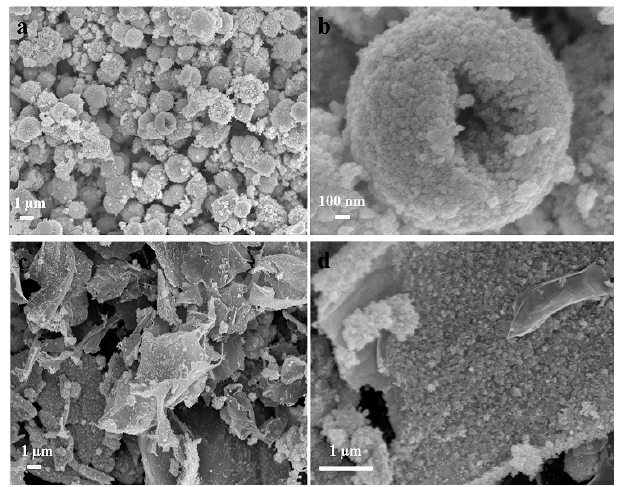
Figure 2. Field-emission scanning electron microscopy (FESEM) images of ( a , b ) bare NiSe and ( c , d ) NiSe/rGO composite.